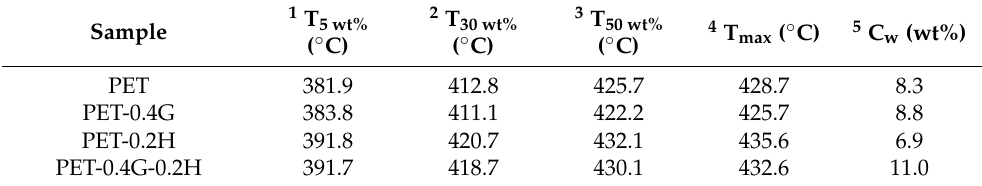
Table 2. Thermal degradation data of neat PET and its composites in N 2